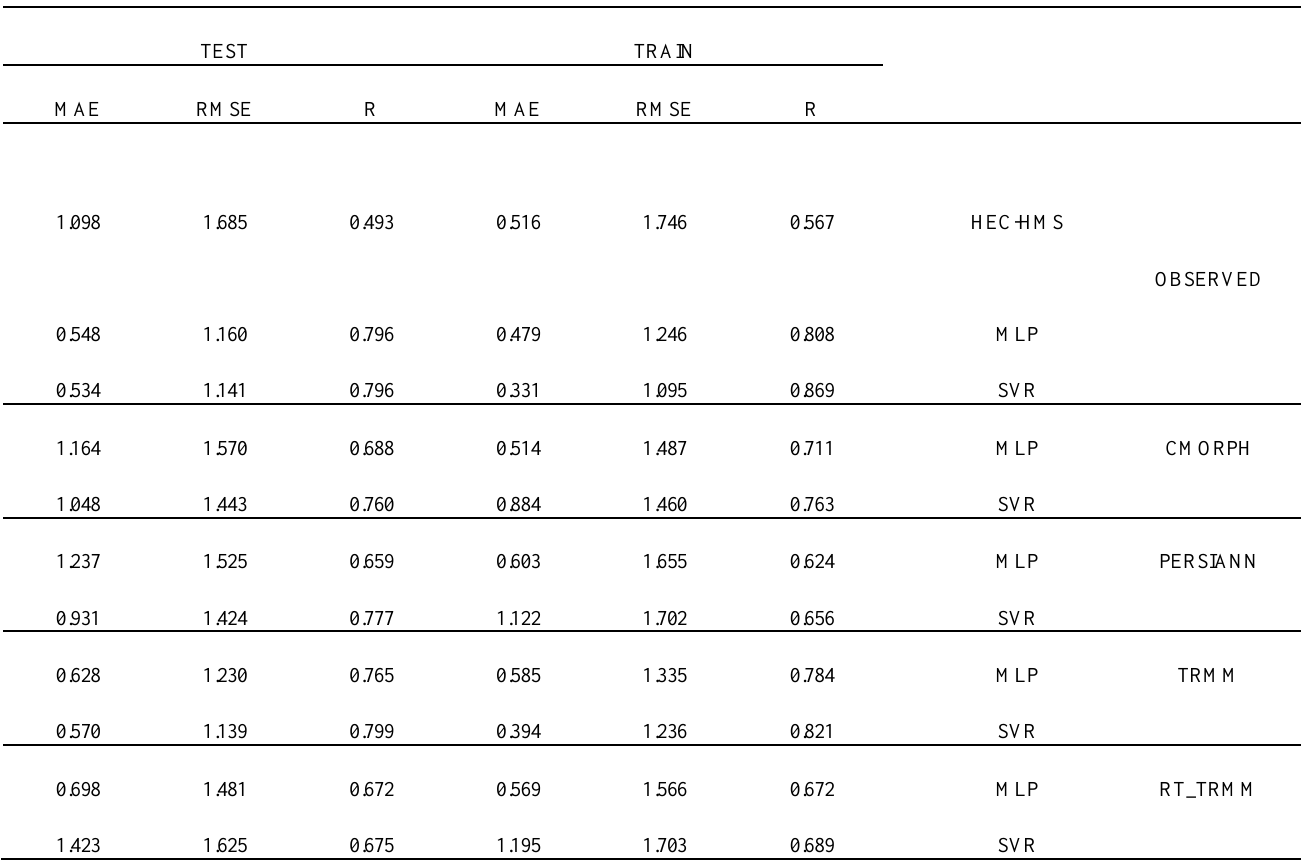
Table 3: The criteria of the efficacy in the simulation of the flow by different models based on satellite data